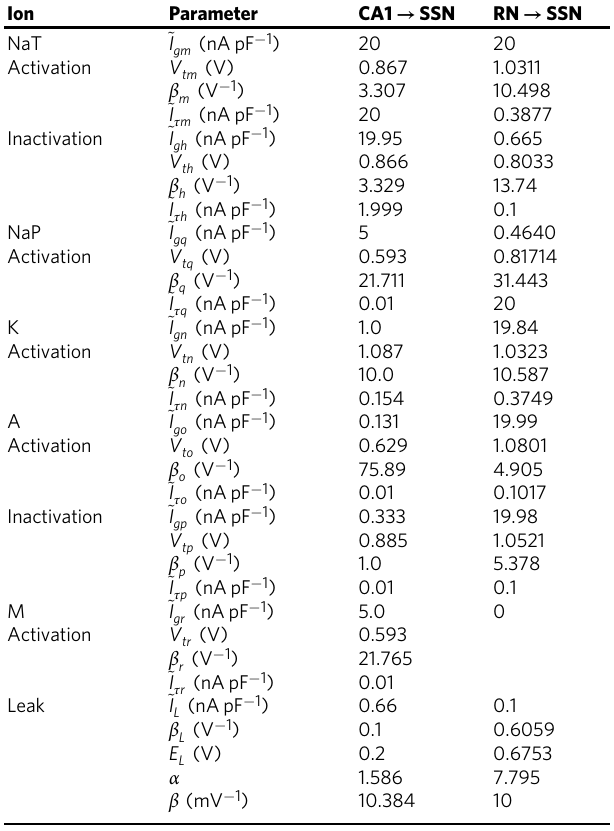
Table 3 SSN parameters extracted from biological neurons.